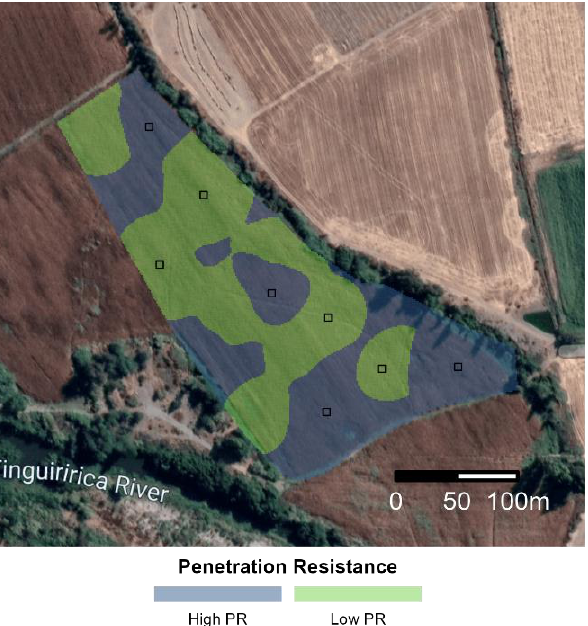
Figure 3. Spatial distribution of PR (0 – 5 cm) at the study site. Areas of high PR (blue) and low PR (green). Sampling sites are indicated with a black square. Cutoff threshold corresponds to the median value (485,000 Pa).